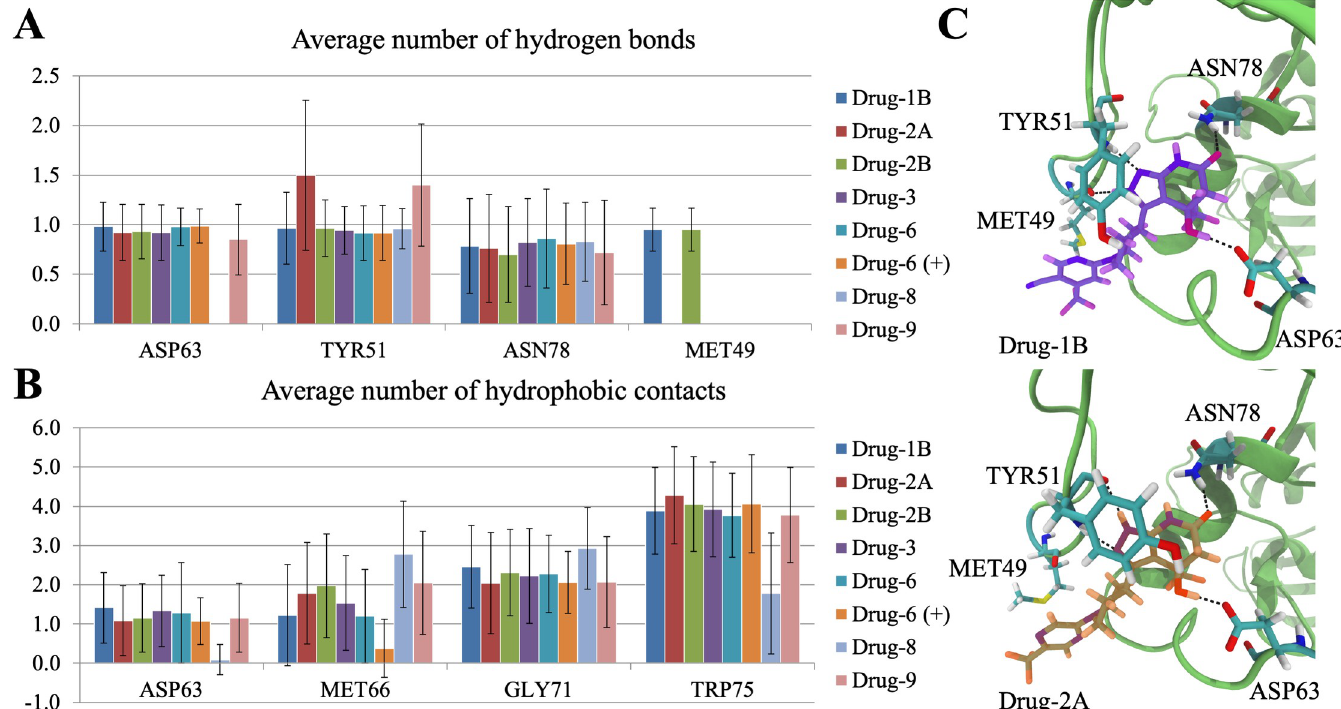
Fig 3. (A) The average number of hydrogen bonds formed between the MBD amino acids and drug compounds during the whole simulation trajectory. (B) The average number of hydrophobic interactions between drugs and amino acids showing the most variation for compound 8 relative to other compounds. (C) Visualization of the primary hydrogen bonding pairs between compounds and LCAT. Snapshots from Drug-1B (Top) and Drug-2A (Bottom) simulations showing the conformations of compounds 1b and 2a in the cleft of MBD. The hydrogen bonds between drugs and amino acids are marked with black dashed lines. Compounds 1b and 2a are rendered as sticks and are colored according to the element types. Compound 1b is hued purple and 2a orange. The MBD cleft is rendered as a cartoon representation and colored green. Amino acids forming hydrogen bonds with compounds are rendered as sticks and colored according to the element types. Carbon atoms are cyan, oxygen red, nitrogen blue, fluorine pink, and sulfur